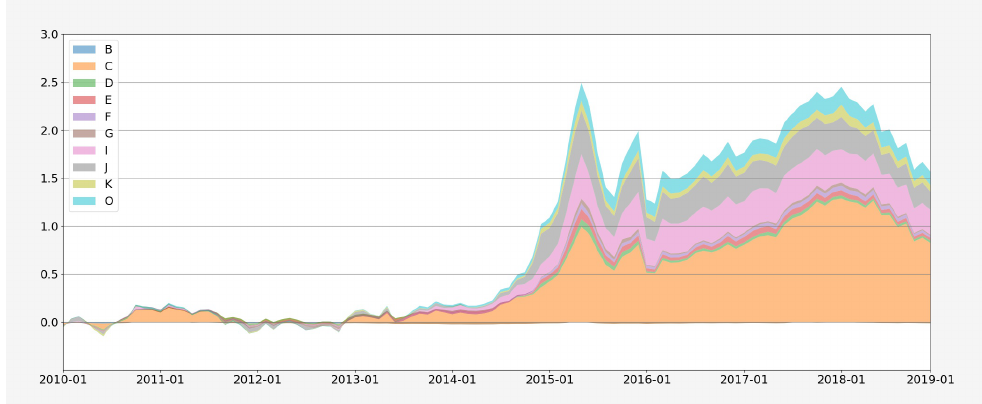
Figure 4. Sectors’ contributions to MCASI’s return. Notes: Figure 4 introduces the contribution of the returns of the sector portfolios on MCASI’s return. The tags and full names of these sector portfolios can be found in Panel A of Table 8. The weights of the returns of the sector portfolios on MCASI’s return are presented in Panel A of Table 11. The relation between MCASI’s return and the sector portfolio’s return is RM t = ∑ k ∈ S W k SecRet k , t , where W k is the weight of the sector portfolio k on MCASI’s return; SecRet k , t is the return of the sector portfolio k for month t ; S is the set of all sector portfolios. The sample period extends from January 2010 to December